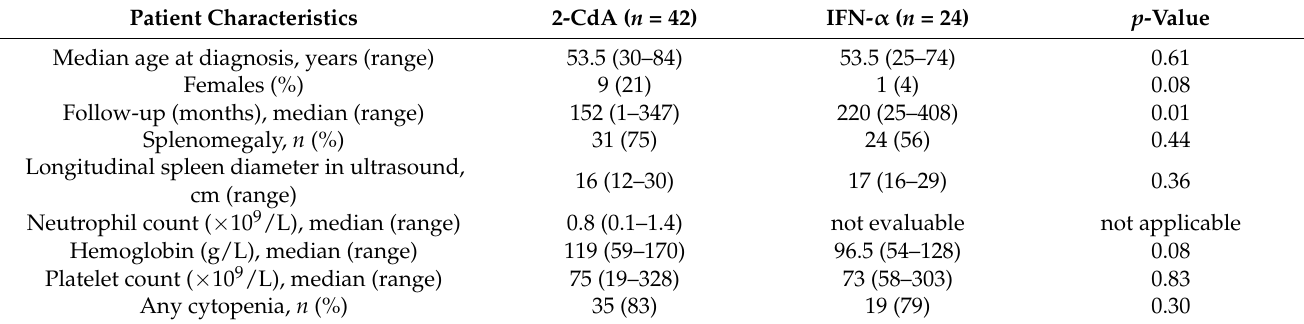
Table 4. Comparison of patient characteristics according to first-line treatment with 2-CdA or IFN- α